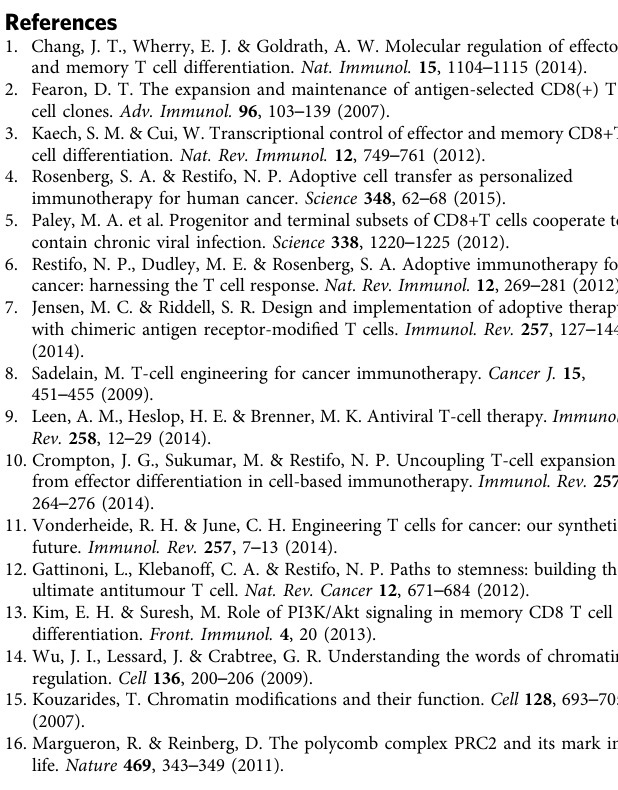
loaded in 4 – 12% Mini-PrROTEAN TGX Precast protein Gels (Bio-rad), and transferred to PVDF membrane. Membranes were blocked in 3% BSA for 1h, incubated with the primary antibody overnight at 4 °C, washed, and incubated with the appropriate horseradish-conjugated secondary antibody for 1h at room tem- perature. An enhanced chemiluminescent (ECL) kit was used to visualize the signal (Thermo Fisher). The Abs used for western blot analysis are listed in Supple- mentary Table 3. Uncropped blots for western blot analysis are shown in Sup- plementary Fig. 11. Flow cytometric analysis and cell lines . The Abs used for fl ow cytometric ana- lyses were purchased from eBioscience, BioLegend, or BD Biosciences. The Ab information is listed in Supplementary Table 3. Flow cytometric analyses were performed with FACS LSRII (BD Biosciences) as described 64,65 . B16 mouse mel- anoma cell line was purchased from American Type Culture Collection, and were cultured in RPMI-1640 medium (Gibco) supplemented with 10% FBS. No mycoplasma contamination was detected in any of the cultures using a myco- plasma detection kit. Statistical analyses . Unless otherwise speci fi ed, statistical tests were performed using unpaired two-tailed Student ’ s t test. Where necessary, the Shapiro – Wilk test was used to test for normality of the underlying sample distribution. No blinding was done, as objective quantitative assays such as fl ow cytometry, were used. Experimental sample sizes were chosen using power calculations with preliminary experiments and/or were based on previously described variability in similar experiments 30,45,50,65 – 67 . Samples that had undergone technical failure during processing were excluded from analyses. Where relevant, recipient mice were randomized before adoptive transfer. p values of 0.05 or less were considered signi fi cant. Data availability . The RNA-seq data has been deposited in National Center for Biotechnology Information Gene Expression Omnibus (GEO)database